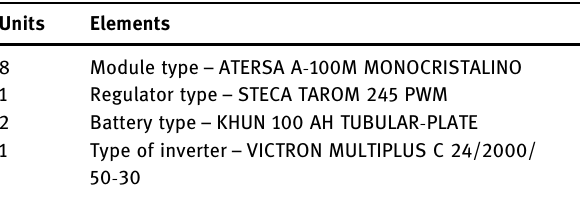
Table 10: Stand - alone PV components ( calculation solar program )